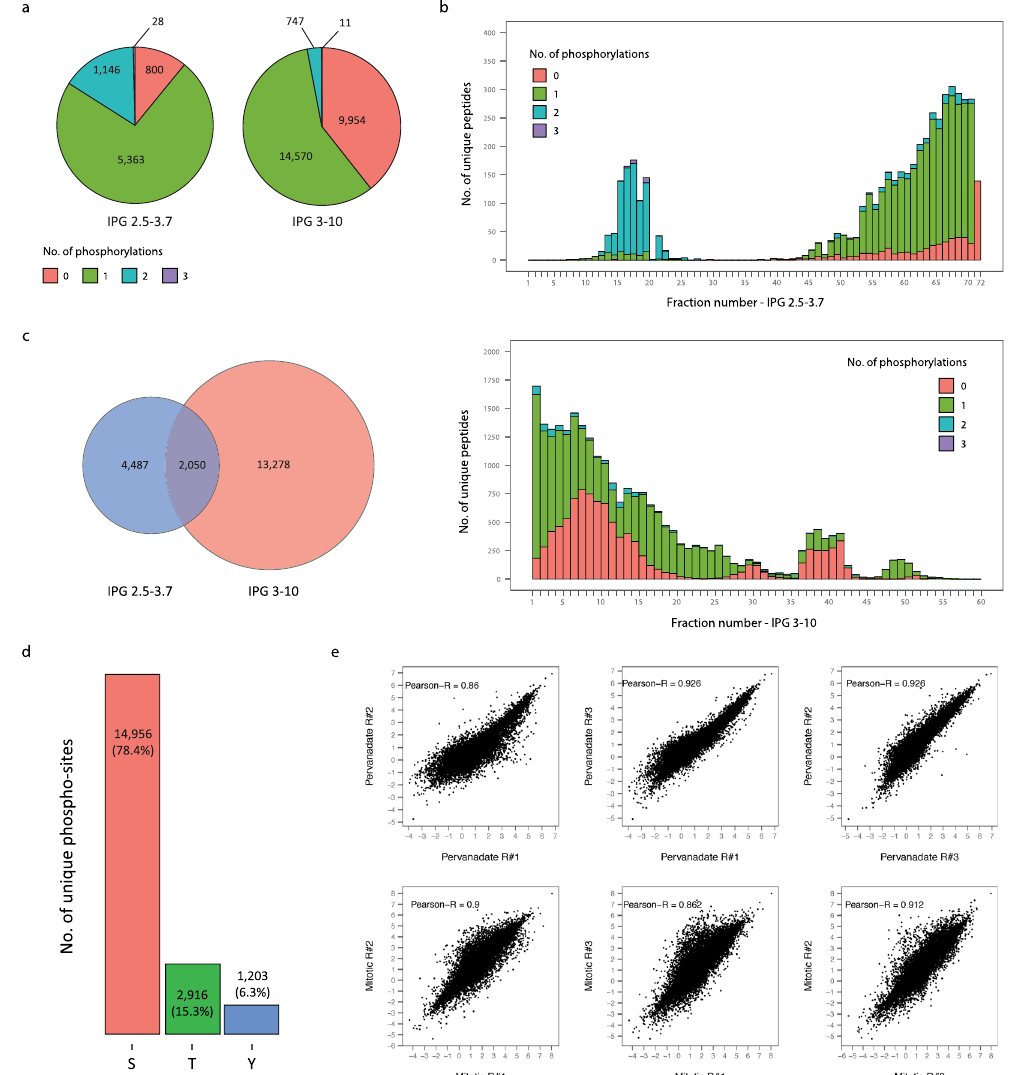
Figure 2. Identifications by and reproducibility of HiRIEF based phosphoproteomics. ( a ) Pie chart representing the number of unique peptides broken down by number of phosphorylations. ( b ) Distribution of unique peptides across HiRIEF fractions, broken down by number of phosphorylations. Fraction numbering proceeds from the acidic end towards the basic end of the strips. ( c ) Venn diagram showing the overlap between unique phospho-peptides identified with the two HiRIEF pH ranges, 2.5–3.7 and 3–10. ( d ) Total number of identified unique phospho-sites, displayed by modified residue (serine, threonine or tyrosine). ( e ) Correlation of phospho-sites log 2 transformed ratio values for each replicate pair; Pearson correlation coefficient is displayed. Ratio values were calculated using as a denominator the average of the four untreated samples, and normalized to total protein levels (see